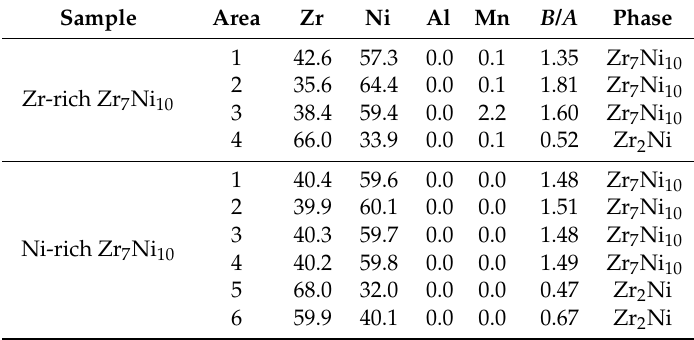
Table 6. Energy dispersive spectroscopy (EDS) phase compositions of select areas for Zr-rich and Ni-rich Zr 7 Ni 10 alloy samples depicted in Figure